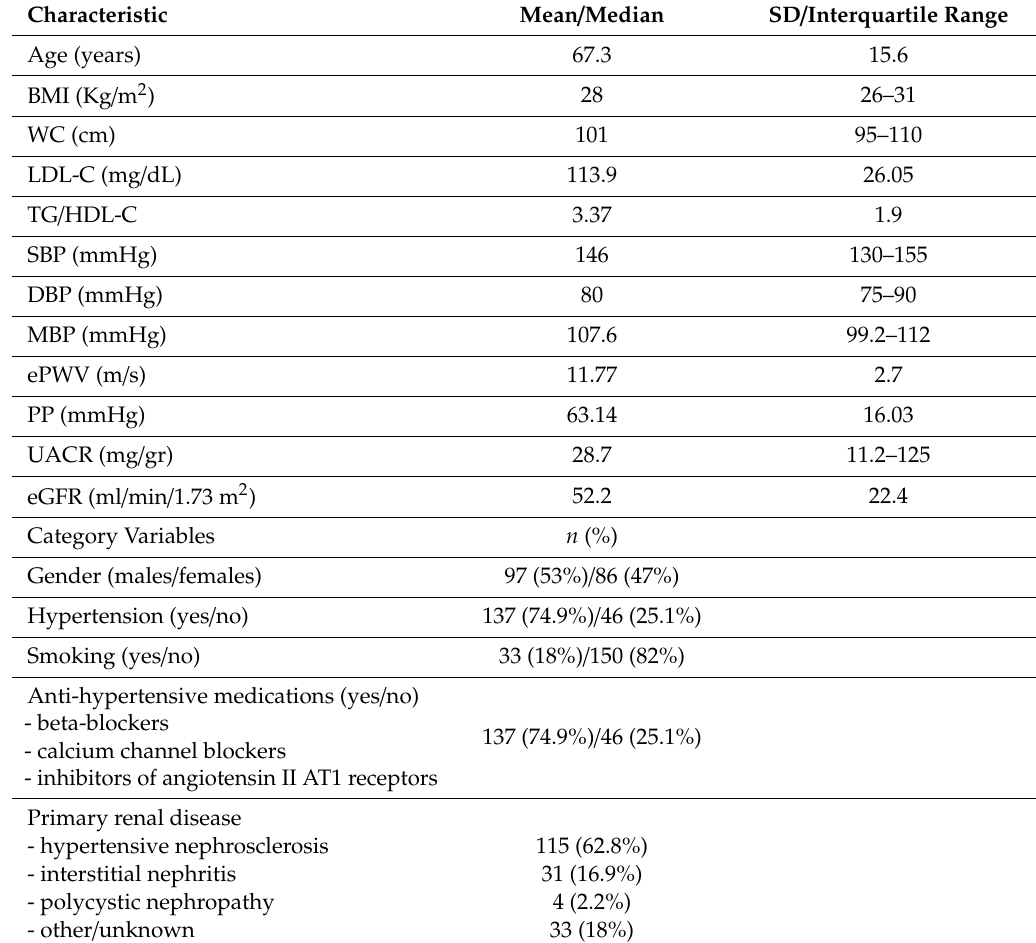
Table 1. Characteristics in the entire cohort ( n =